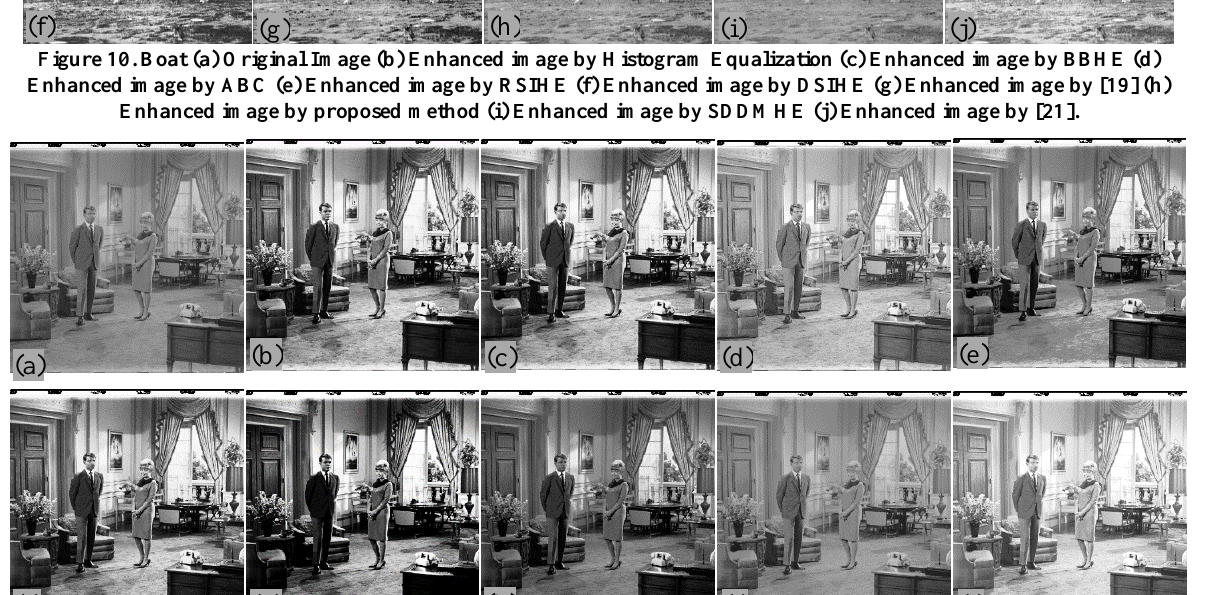
Figure 11. Couple (a) Original Image (b) Enhanced image by Histogram Equalization (c) Enhanced image by BBHE (d) Enhanced image by ABC (e) Enhanced image by RSIHE (f) Enhanced image by DSIHE (g) Enhanced image by [19] (h) Enhanced image by proposed method (i) Enhanced image by SDDMHE (j) Enhanced image by [21].